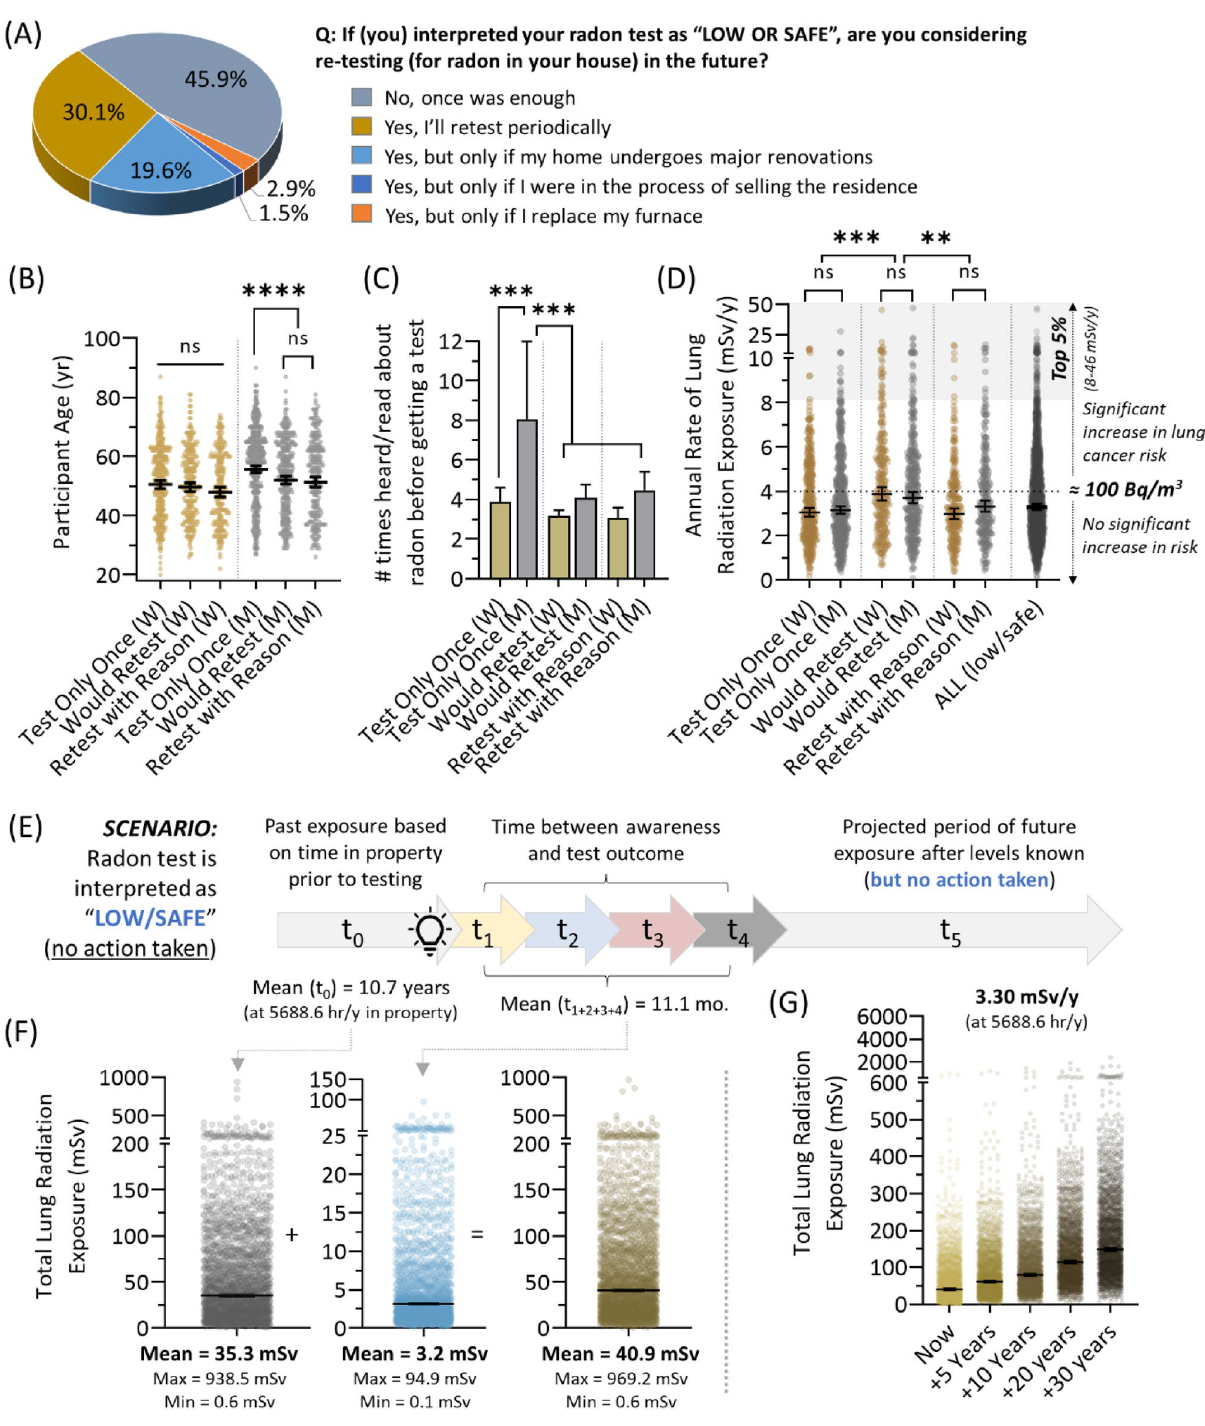
Figure 4. Behaviours and radiation doses to the lungs of people interpreting their radon as low or safe. ( A ) Distribution of stated intentions after gaining direct knowledge of primary residence radon levels, for those who interpreted their outcome as ‘low or safe’. ( B ) Distribution of participant ages as a function of sex/gender for each intention category based on ( A ). ( C ) For groups defined by ( A,B ), the number of times each needed to hear or read about radon before obtaining a radon test. ( D ) For groups defined by ( A,B ), the annual rate of lung radiation from residential radon experienced by individuals. ( E ) A schematic indicating the time periods (t 0 to t 5 ) influencing radon gas exposure in residential properties for which radon levels were interpreted as ‘low or safe’. t 0 and t 1+2+3+4 values = geometric means. ( F ) Scatter plots of total lung radiation experienced by individuals who identify their radon levels as ‘low or safe’. Mean values refer to geometric means. ( G ) Based on current (‘now’) total exposures (calculated in ( F )), a projection of future total dose of radiation to lung from primary residential radon over a 5–30-year period, for those who interpret their radon levels as ‘low or safe’. Statistical comparisons are Mann–Whitney pairwise nonparametric t-tests of comparisons for scatter plot data. ****p < 0.0001; ***p < 0.001; **p < 0.01; ns = p > 0.05. Figures were prepared using Excel and GraphPad Prism 9.1.1 (225) (www. graph pad.